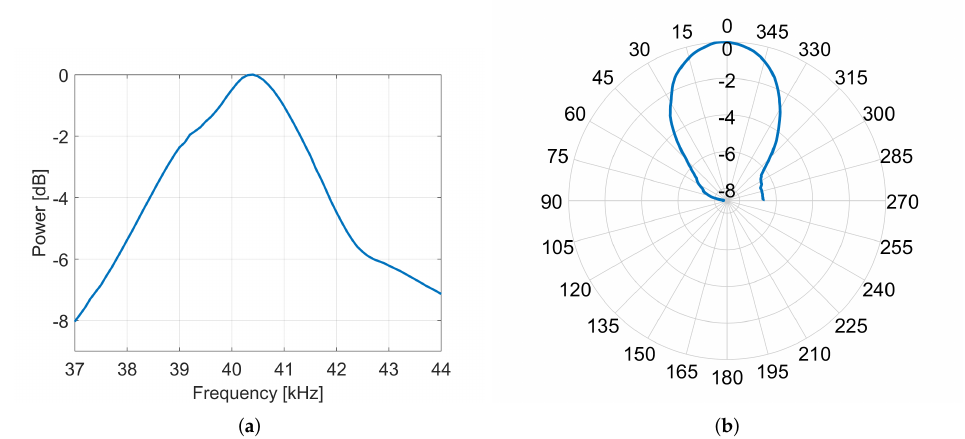
Figure 3. ( a ) Transducers frequency response in the band [ 37,44 ] kHz and ( b ) radiation pattern at the frequency of 40 kHz. The pattern is approximately the same in both horizontal and vertical